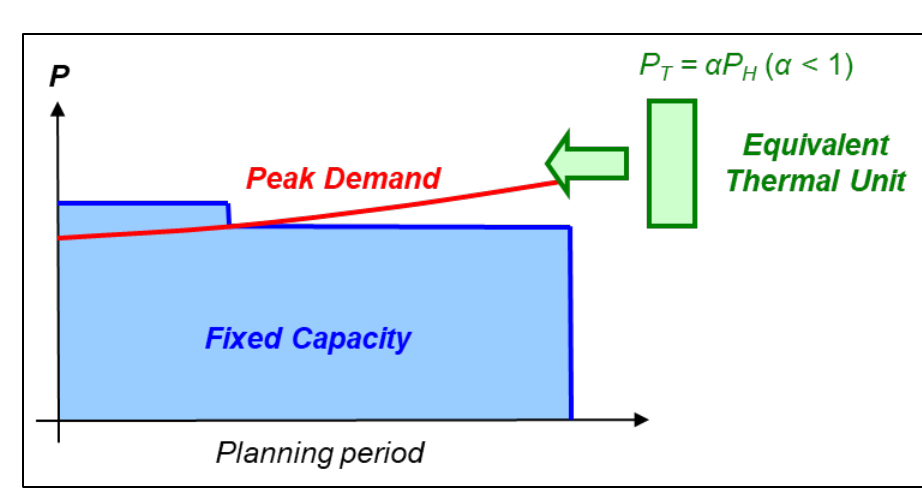
Figure 9. Modeling a large hydro plant as an equivalent thermal unit.